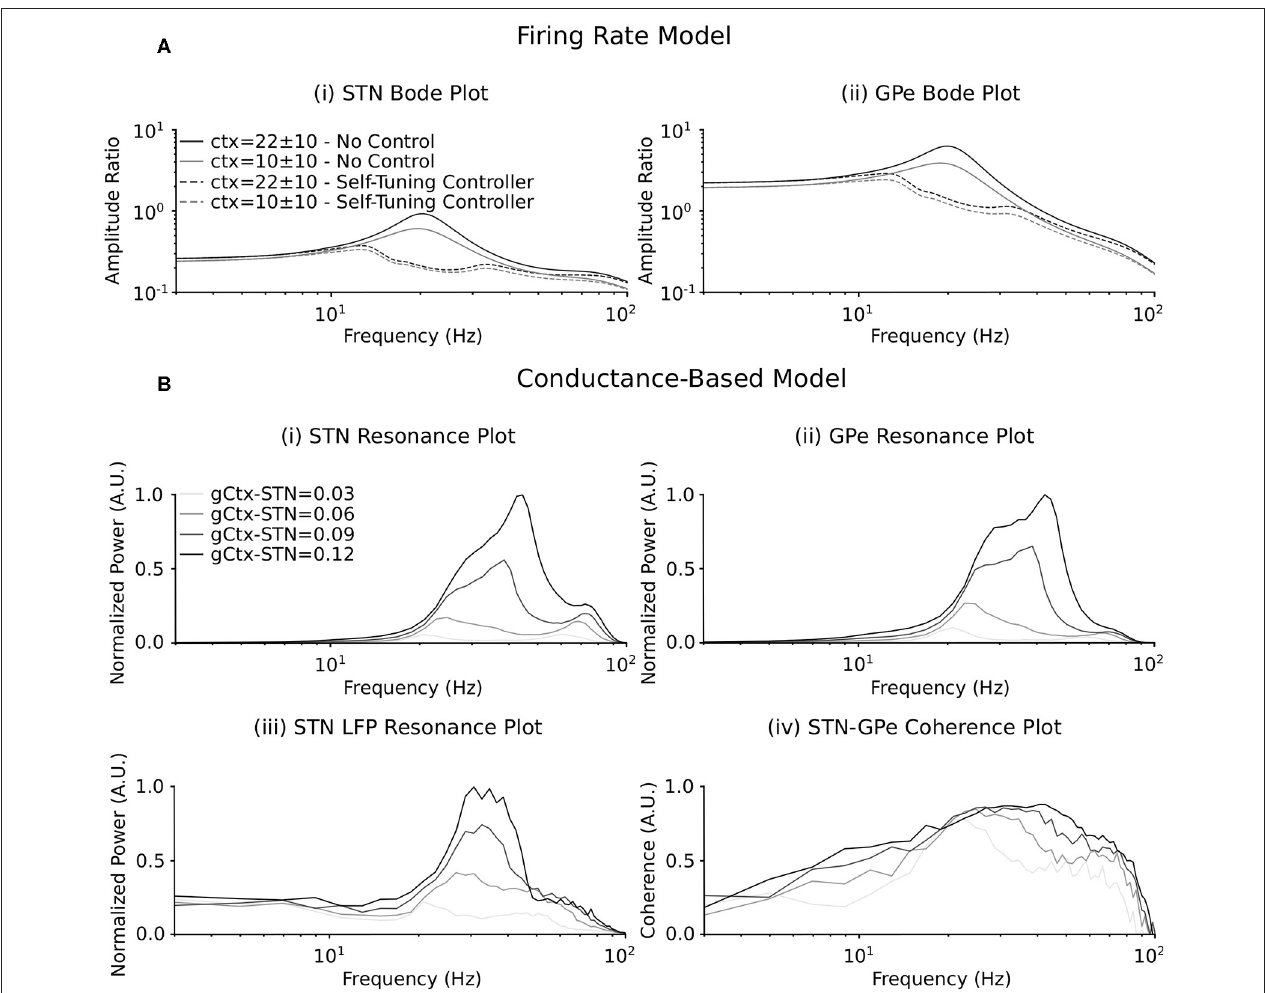
FIGURE 3 | Resonance behavior of the firing rate and conductance-based models in response to synchronous cortical drives. (A) Bode plot illustrating amplification of cortical input signals of varying frequency by the (i) STN and (ii) GPe populations in the firing rate model. The amplitude ratio is defined as the amplitude of the input oscillation (the cortical input signal) to the amplitude of the steady state oscillation in the (i) STN and (ii) GPe populations at each cortical input frequency. Solid lines represent the frequency response of each population when DBS is off. Dashed lines represent the frequency response of each population when the self-tuning DBS (7) is implemented with σ = 0.1 and τ θ = 50 ms. Two mean values of the cortical input signal are represented. (B) Resonance plot of the power centered at the cortical input frequency in the (i) STN and (ii) GPe cumulative spike trains, (iii) the STN LFP power spectrum and (iv) the coherence between the STN and GPe populations for varying cortical input frequencies. Power at the cortical input frequency was estimated in the cumulative spike trains and LFP power spectra by integrating the power in a 4 Hz window centered on the input frequency in the respective power spectra. The coherence between the STN and GPe populations at the cortical input frequency was estimated from pairs of composite spike trains randomly chosen from the STN and GPe populations (Farina et al., 2014; McManus et al., 2019). The spike trains in the STN and GPe were summed to obtain two composite spike trains. The magnitude squared coherence between the two composite spike trains was then calculated with 1 s overlapping Hamming windows. This was repeated for 200 randomly chosen combinations of spike trains from the STN and GPe populations, as each combination will generate a slightly different coherence estimate. The coherence between the populations was then estimated as the median coherence spectrum over all 200 combinations. The coherence at the cortical input frequency was determined by integrating the resulting coherence spectrum in the 4 Hz window centered on the input frequency. Four cortical to STN connectivity strengths are represented, where the resonance responses are normalized between 0 and 1 in each panel